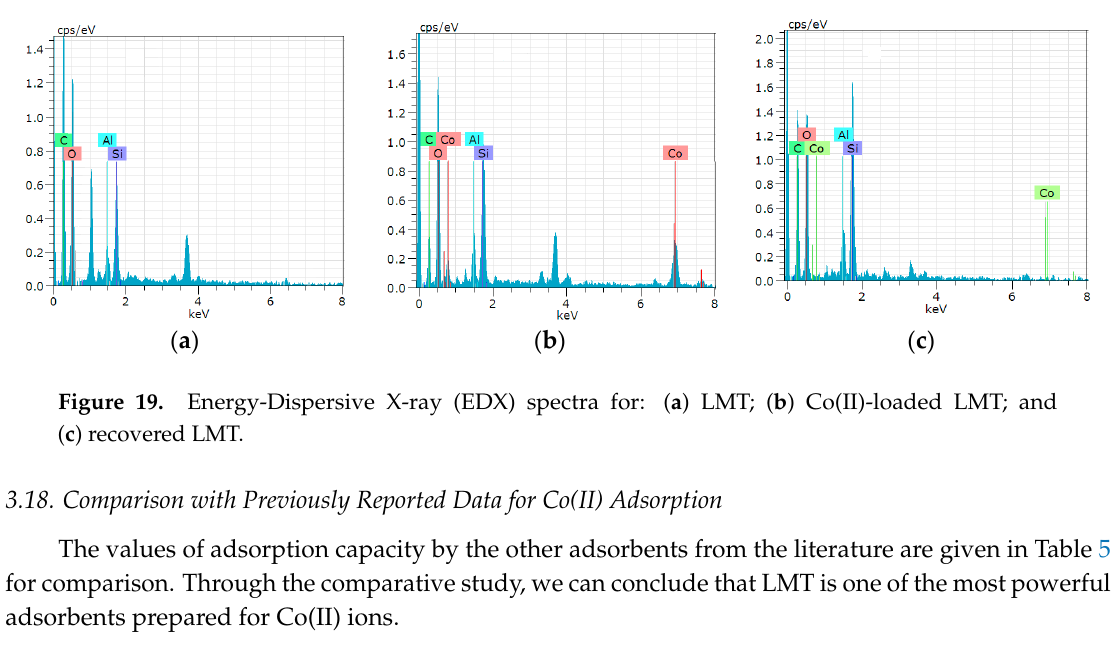
Table 5. Comparison of Co(II) adsorption capacity by various adsorbents from the literatures. Adsorbent Material Adsorbent